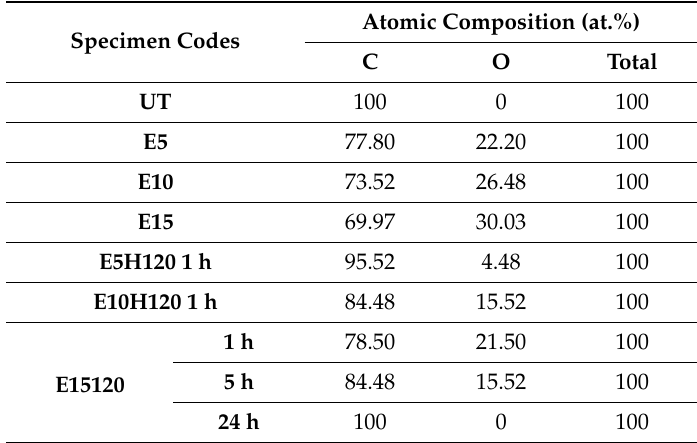
Table 2. Atomic composition of the plasma etching and thermal aging treatment of the specimen for various durations. Atomic Composition (at.%) Specimen Codes C